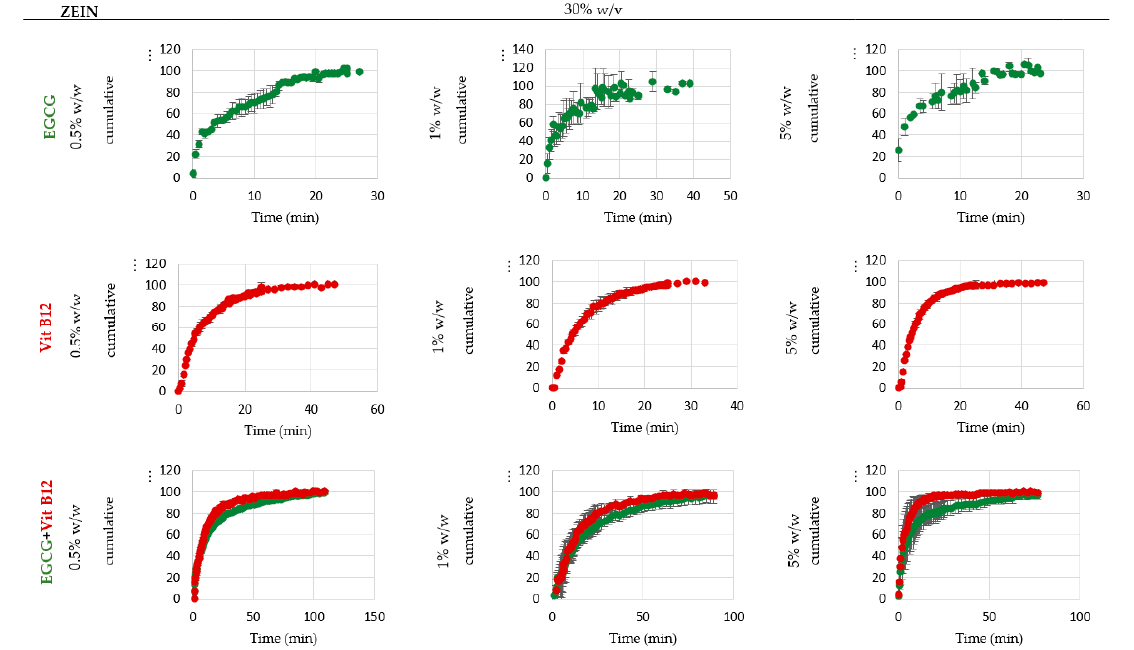
Figure 4. In vitro release profiles, % of EGCG/VitB12/(EGCG + VitB12) normalized by the total amount released, in H 2 O of the microstructures (electrospinning) loaded with 0.5%, 1%, and 5% w / w of active compounds and 30% w / v zein. In a first approach, it is evident that most samples present a similar release behavior, with the exception of EGCG samples containing 1% and 5% w / v zein, which show immediate release. For all other samples, it is possible to distinguish two different zones: the release zone, which is identified by the increase of the core release, and the stabilization zone, characterized by a stabilization of the